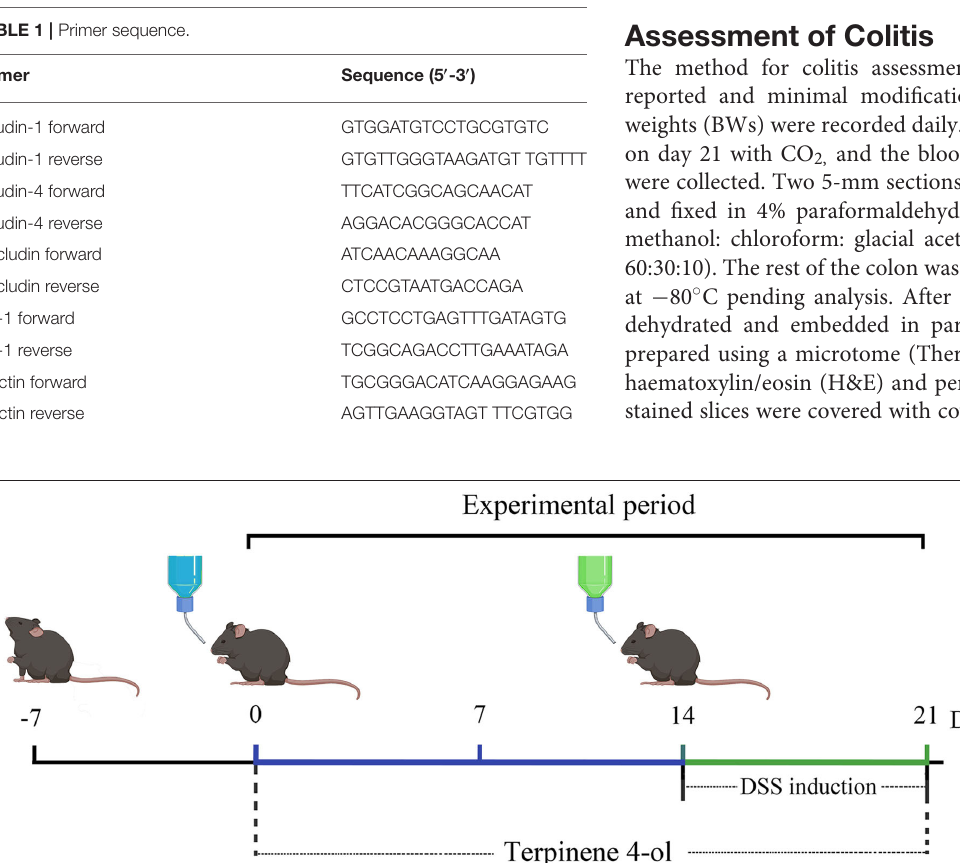
Frontiers in Nutrition |